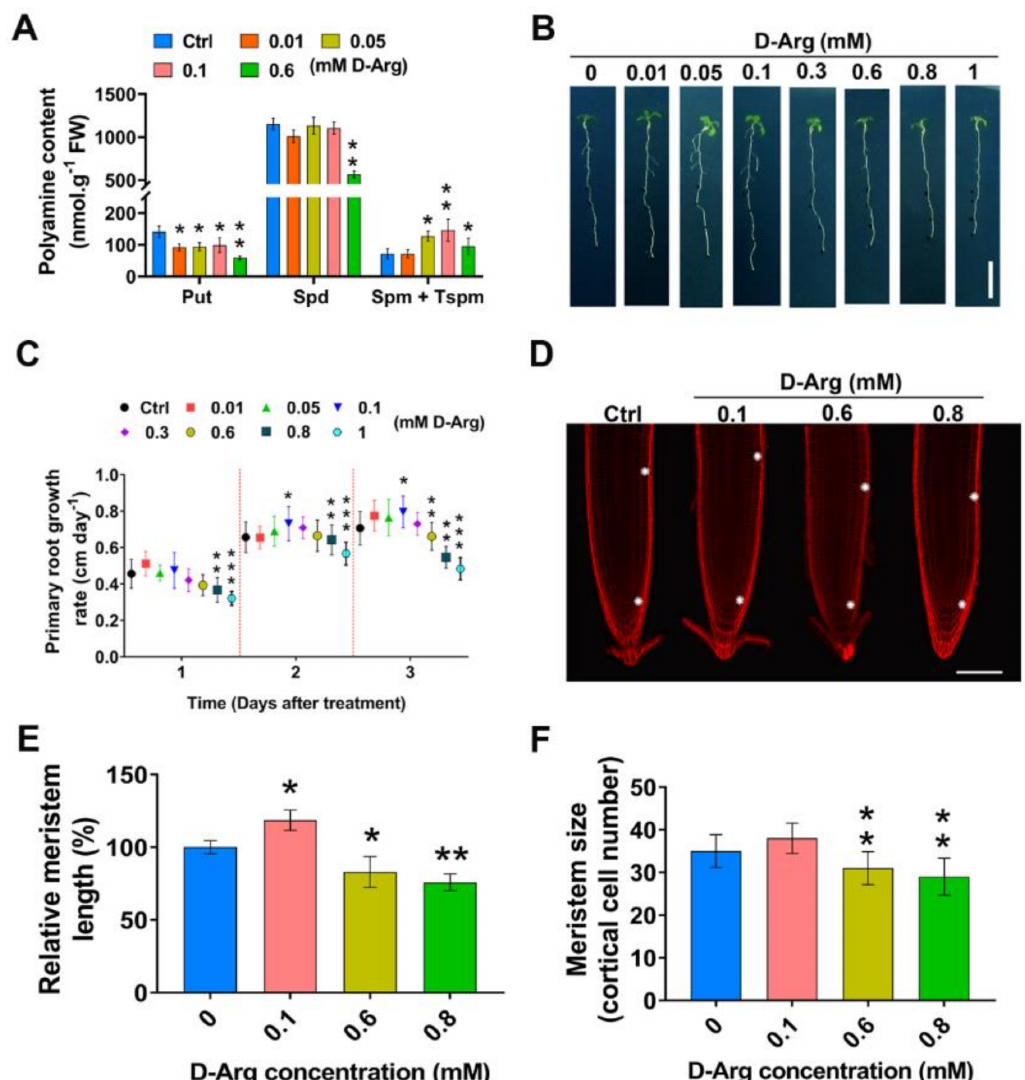
Figure 2. ADC1/2 inhibition differentially modifies polyamine (PA) content and affects root growth and meristematic zone (MZ) size in a non-linear concentration-dependent manner. Five-day-old seedlings at the same developmental stage were transferred to new media containing water (Ctrl) or D-Arg and were treated for 3 days. ( A ) Differential effect of D-Arg treatment on polyamine content. Putrescine (Put), spermidine (Spd), and spermine plus thermo-spermine (Spm + Tspm) levels were measured using HPLC. ( B ) Whole seedling phenotype shows a non-linear effect of increased D-Arg treatment. Scale bar = 1 cm. ( C ) Daily new root growth length varies for different D-Arg concentrations. ( D ) Root meristem imaging, using PI staining and confocal microscopy, exhibits the non-linear effects of D-Arg on MZ size. Two white asterisks on each root indicate the quiescent center (QC) (bottom) and first elongated cell (top). Scale bar = 100 µ m. ( E ) Meristem cell length normalized to control. ( F ) Cortical cell number in the meristem zone. Data shown are averages ± SD (n > 30). Asterisks denote significant differences compared with the control (* p < 0.05, ** p < 0.01; Student’s t